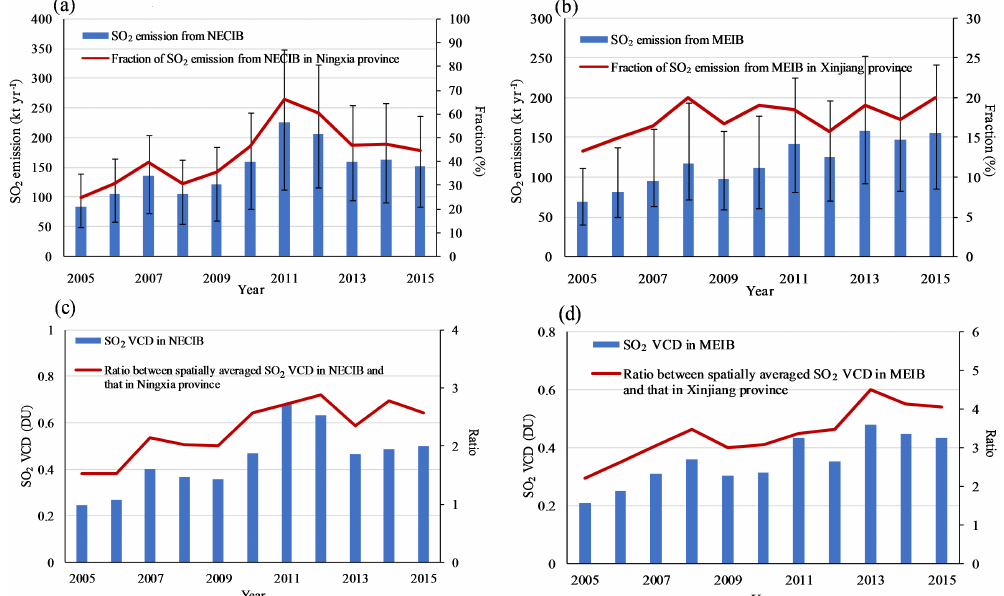
Figure 11. Annually averaged SO 2 emissions (ktyr − 1 ) and SO 2 VCD (DU) in the NECIB and MEIB as well as their fractions in provincial total SO 2 emissions and ratios between SO 2 VCD in these two regions and that in the provinces. (a) SO 2 emissions (blue bar) in the NECIB and its fraction (red solid line) of the total provincial SO 2 emissions in Ningxia. The left y axis is SO 2 emissions, the right y axis denotes the fraction (%) at the upper panel, and the error bars denote the standard deviations of source-detection-algorithm-estimated SO 2 emission point sources; (b) same as Fig. 11a but for the MEIB. (c) . SO 2 VCD (blue bar) in the NECIB and the ratio (red solid line) between SO 2 VCD in the NECIB and that in Ningxia. The left y axis stands for SO 2 VCD (DU) and the right y axis denotes the ratio at the lower panel; (d) same as Fig. 11c but for the